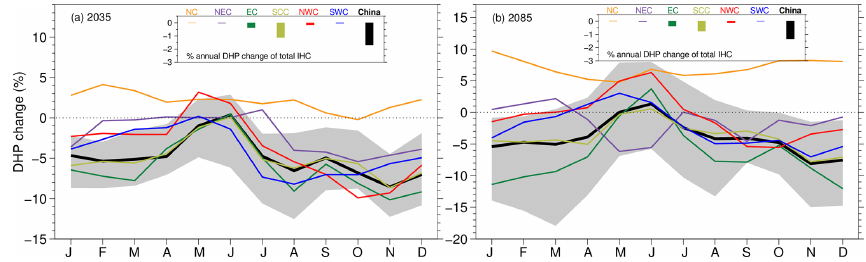
Figure 7. Relative monthly DHP changes in regions in China for 2020–2050 (a) and 2070–2099 (b) under RCP8.5. Lines show the ensemble medians across all GCM-GHM combinations; grey areas show the IQR of relative DHP changes in China; the inner plots show annual DHP changes in regions in terms of the percentage of